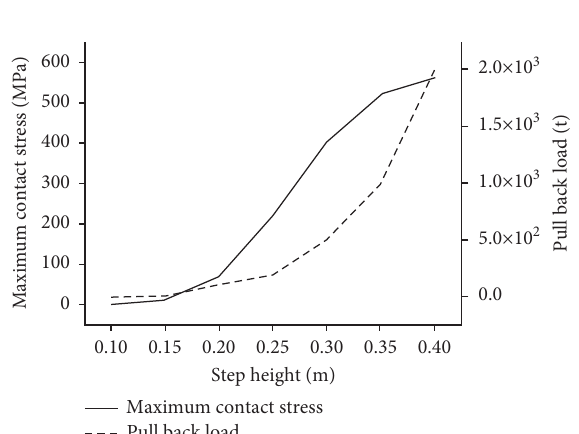
Figure 6: Change curve of pullback force.